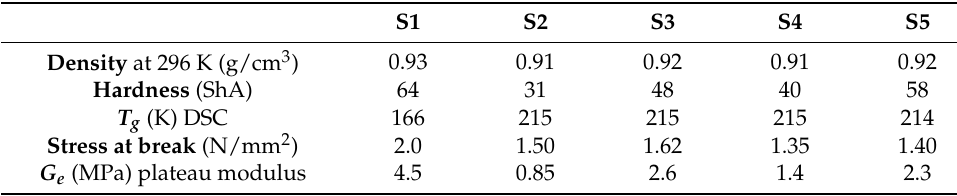
Table 4. Some thermal and mechanical properties of the investigated